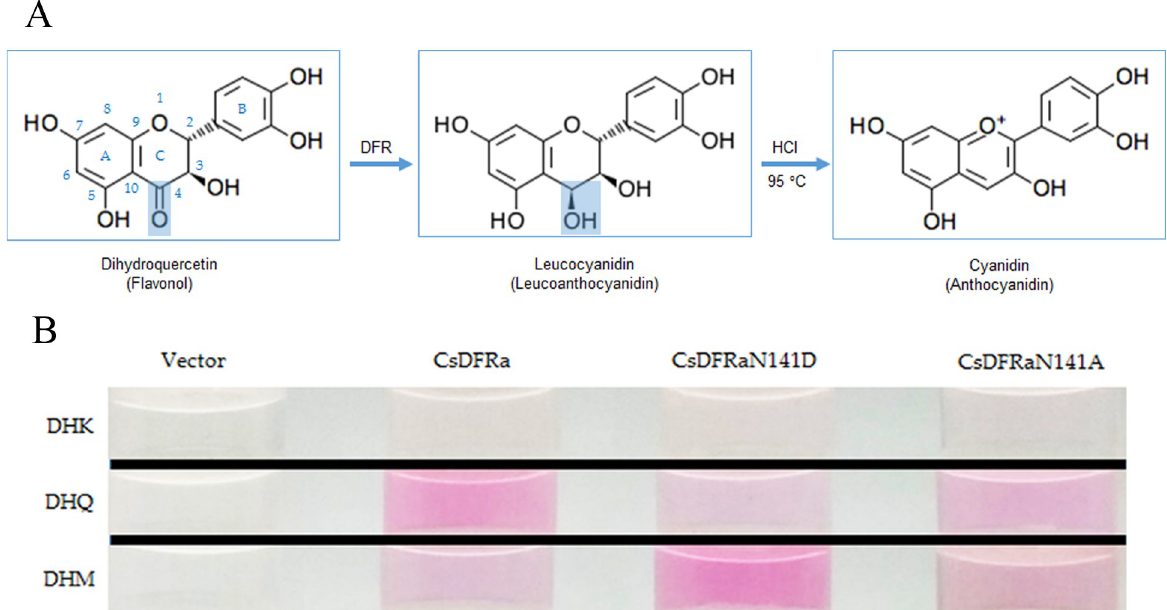
Fig 6. Anthocyanidins generated from leucoanthocyanidins produced by prokaryotic expressed CsDFRa and its mutants. (A) A schematic diagram depicts the reaction process. (B) Anthocyanidin products in reaction tubes. Among six putative CsDFRs, only CsDFRa exhibited enzyme activity on DHFs, while other five CsDFRs’ results were similar to that of the control group which was added with the protein expressed by the pET-32a vector.